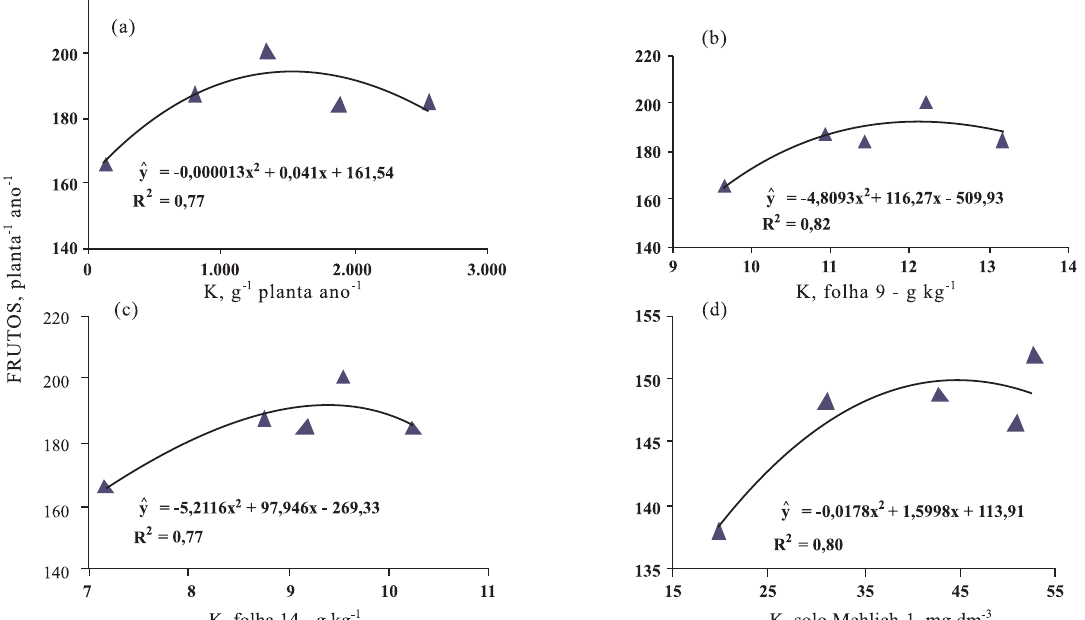
Figura 3. Efeitos do K na produção de frutos (a) e relação entre os teores de K nas folhas 9 (b), 14(c), no solo(d), e a produção de frutos (d) em coqueiros de seis anos de